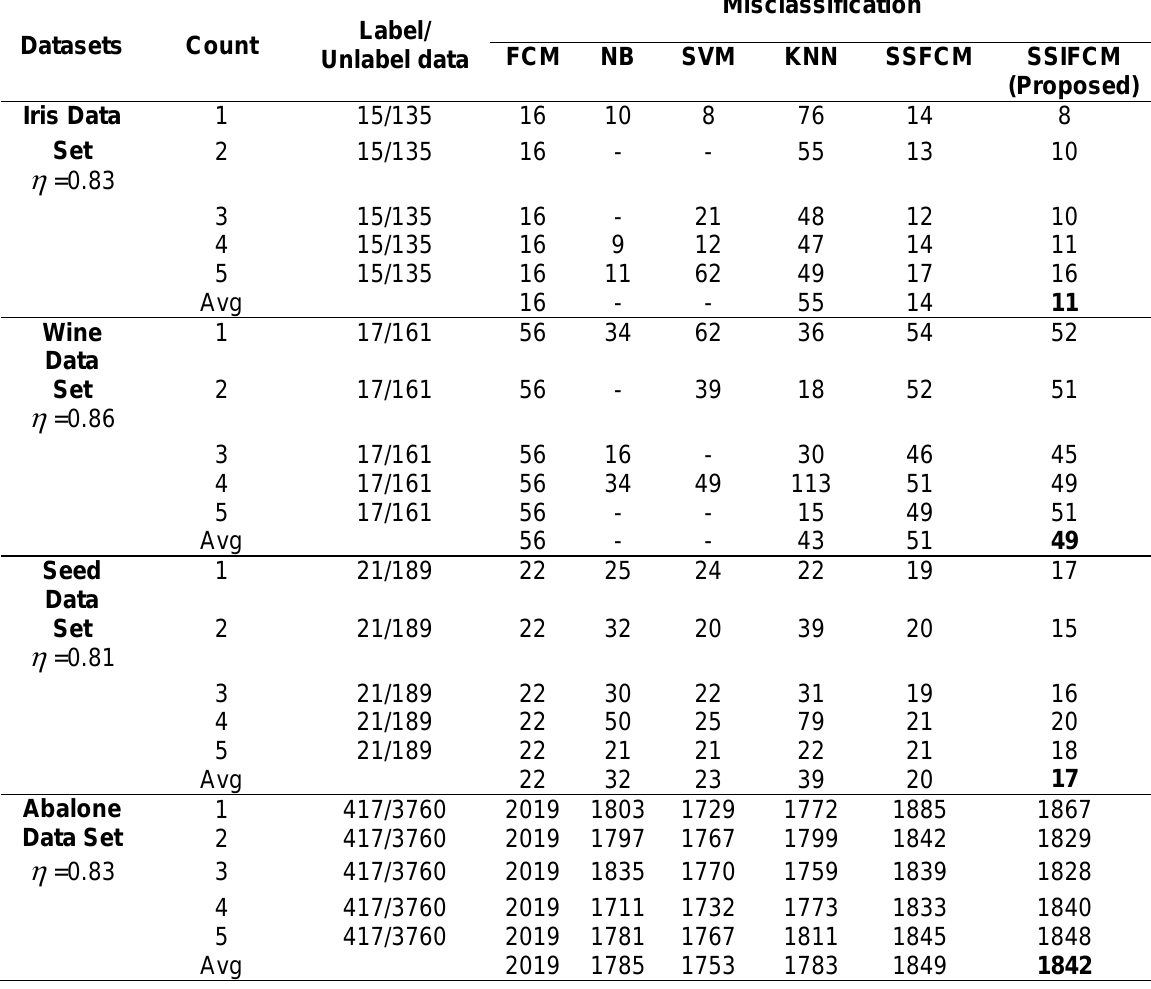
Table 3 . Misclassifications obtained in different lear ning techniques in comparison to the proposed SSIFCM technique with 10% label